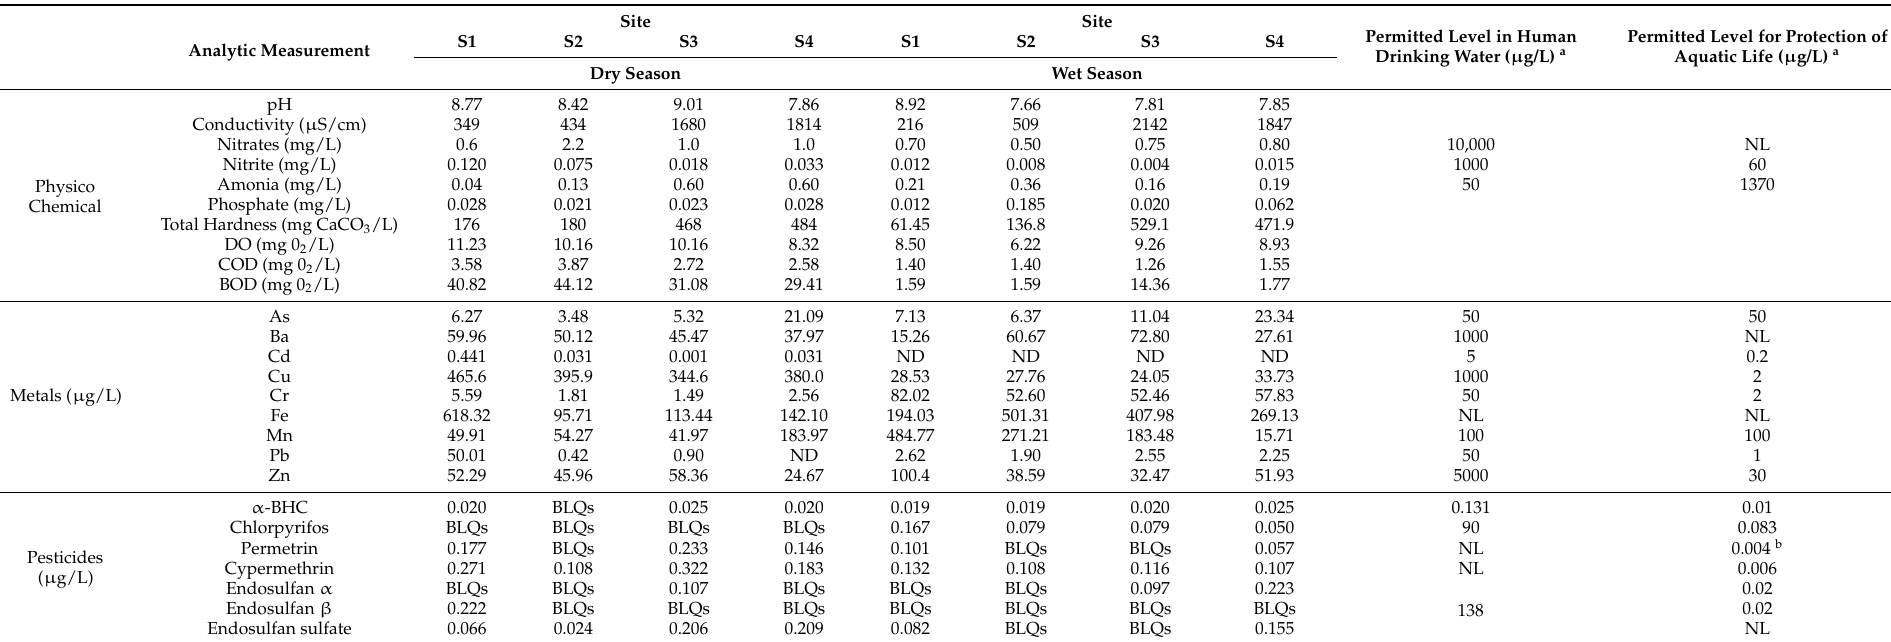
Table 1. Environmental stressors (physicochemical, metals, and pesticides) measured in water samples at the four study sites (S1 to S4) in the Conlara River (San Luis, Argentina) in the dry and wet